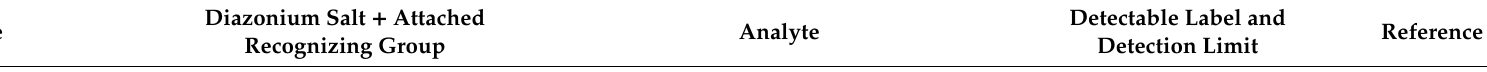
Table 3. Detection of toxins. SWCNT—single-walled carbon nanotube.